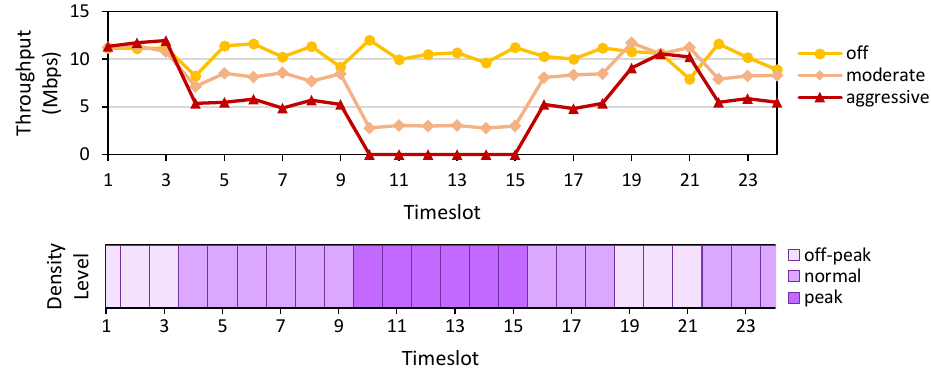
Figure 4. The experiment results for the Internet profile (from ( top ) to ( bottom )) show the average throughput per timeslot using different Internet profiles and the recorded density level per